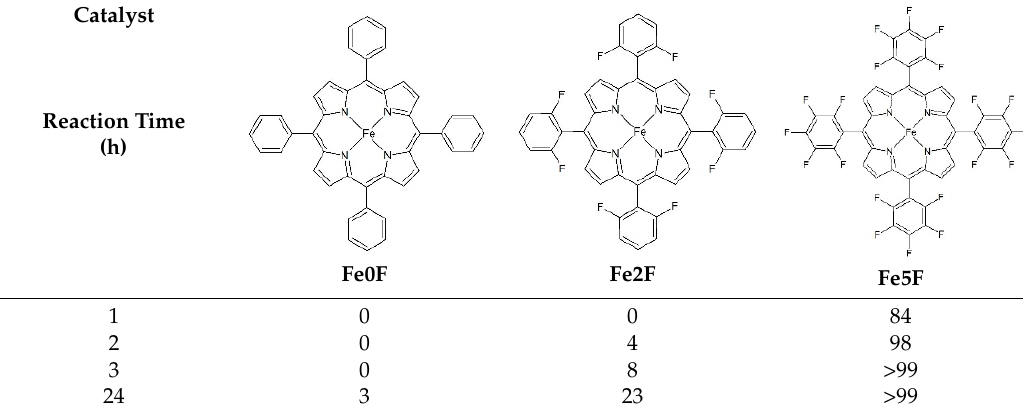
Catalyst Catalyst Catalyst Reaction Time